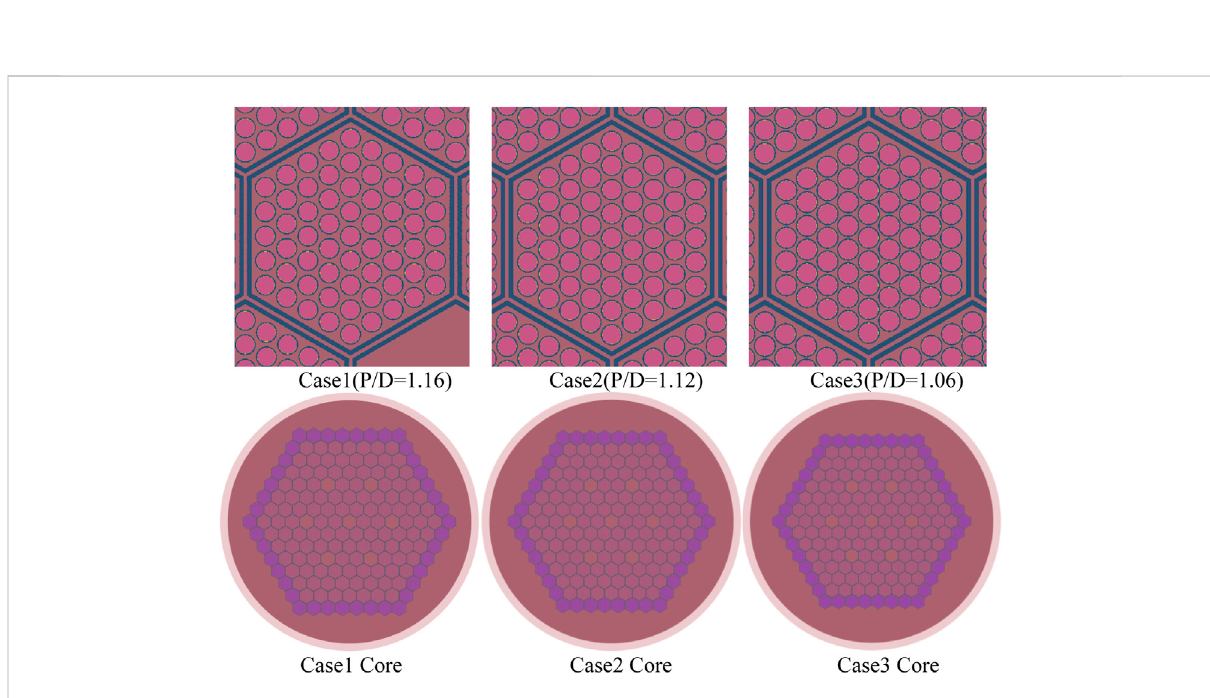
FIGURE 9 Fuel assembly and core structure in the pitch-to-diameter ratio